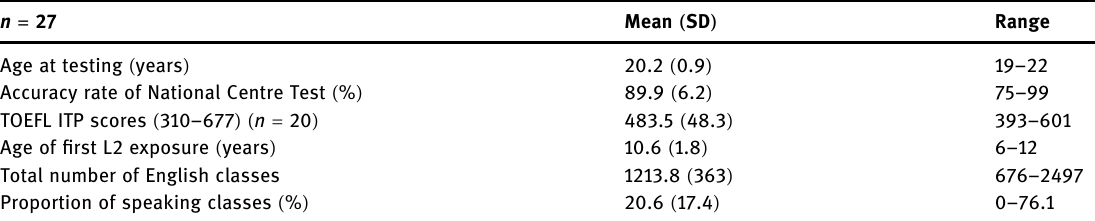
Table 1: Japanese EFL learners ’ linguistic background n = 27 Mean ( SD ) Age at testing ( years